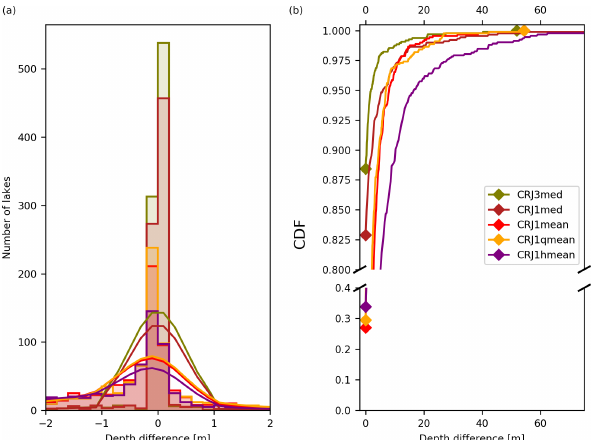
Figure 7. The histogram (a) and cumulative density function (b) of the depth errors between the observed and simulated lake for each depth parameterization strategy. In (a) , the lines correspond to the smoothing of the histogram with a Gaussian window.